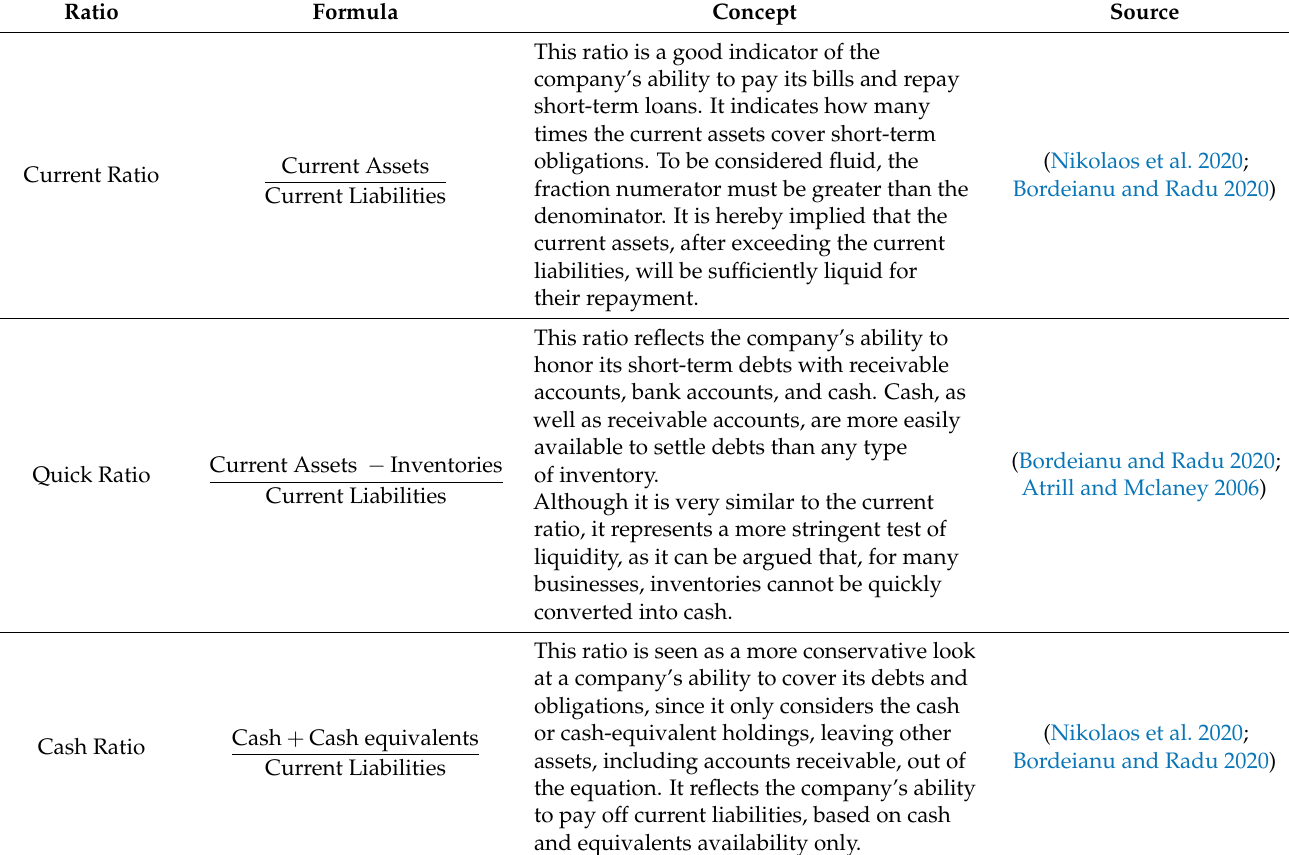
Table 1. Liquidity